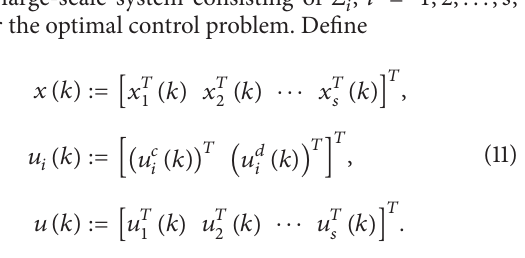
Figure 2: Directed graph expressing